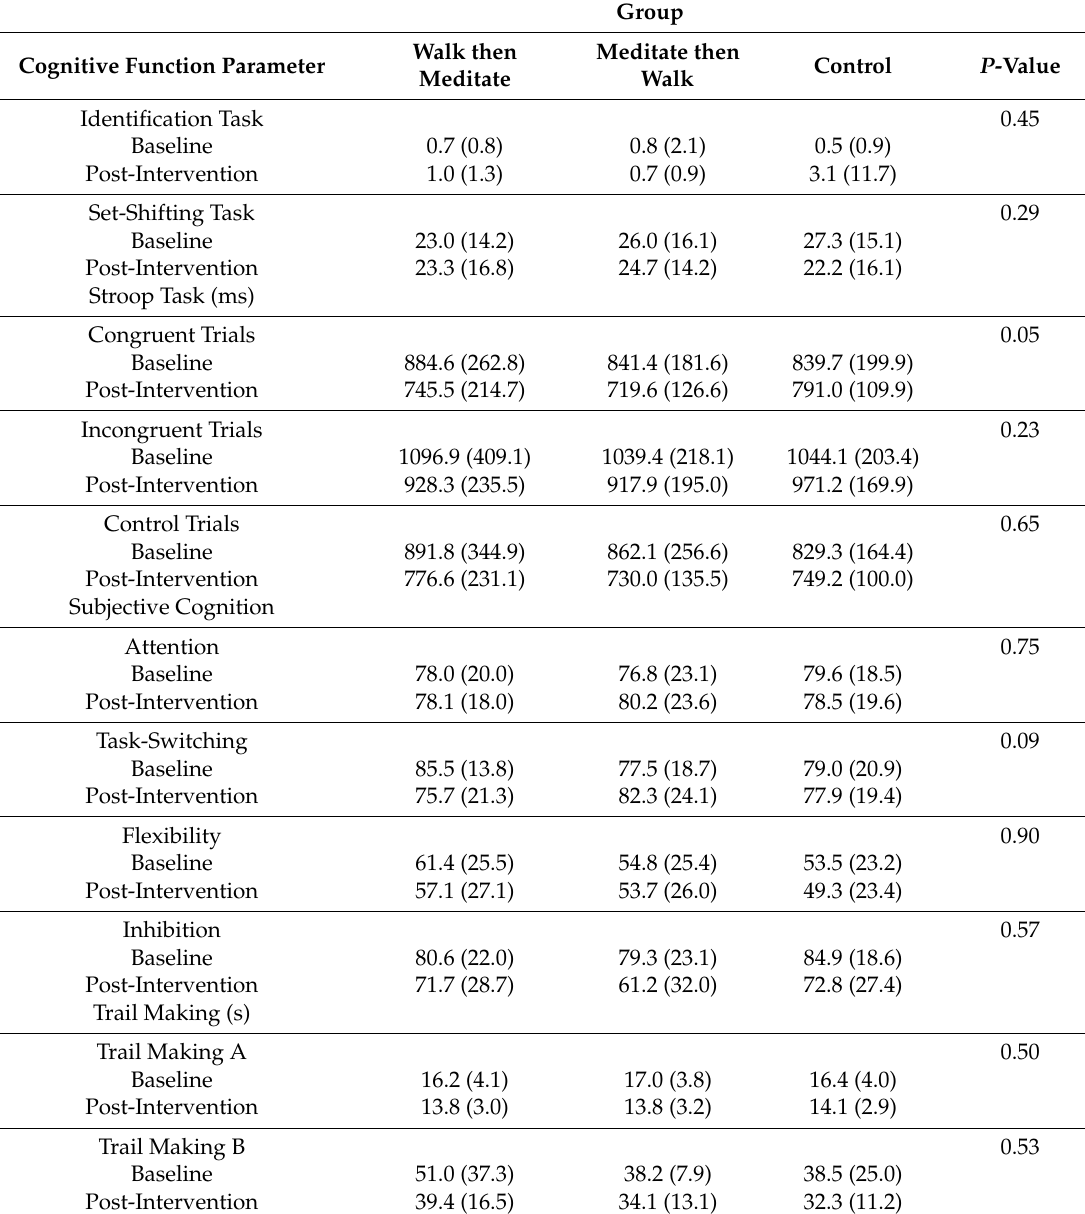
Table 2. Baseline and post-intervention cognitive function scores.